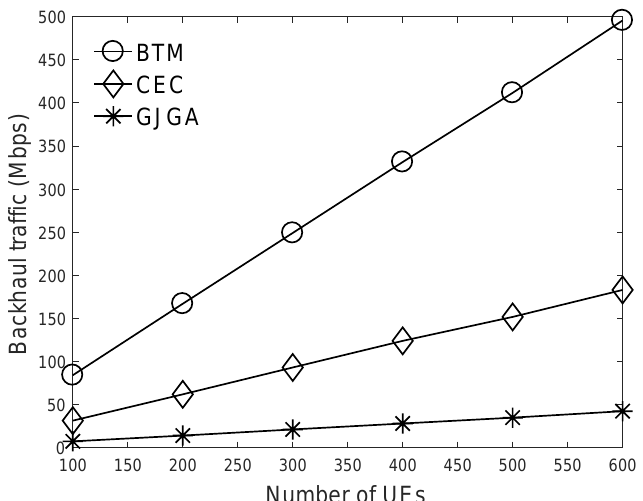
Figure 6. Effects of the UE number on the total backhaul traffic under the cache size of 4000 and 8000 video